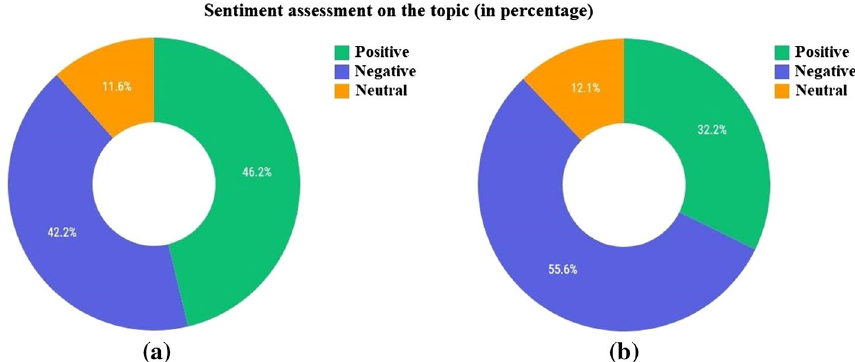
Fig. 24 Evaluation of the sentiment of the first period— a Almaty and Nur-Sultan, b large regional